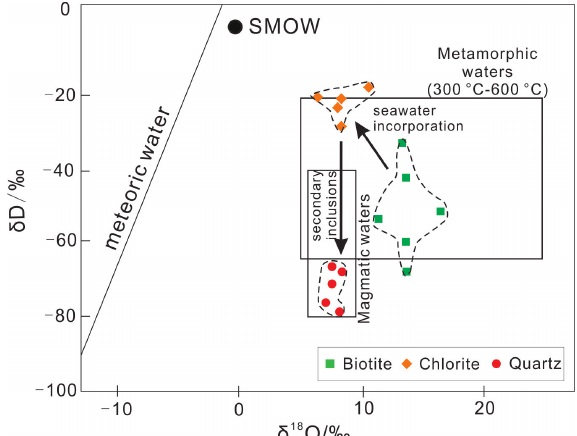
Figure 10. Hydrogen and oxygen isotope plot for biotite, chlorite, and quartz from the Tongkuangyu Cu deposit, North China